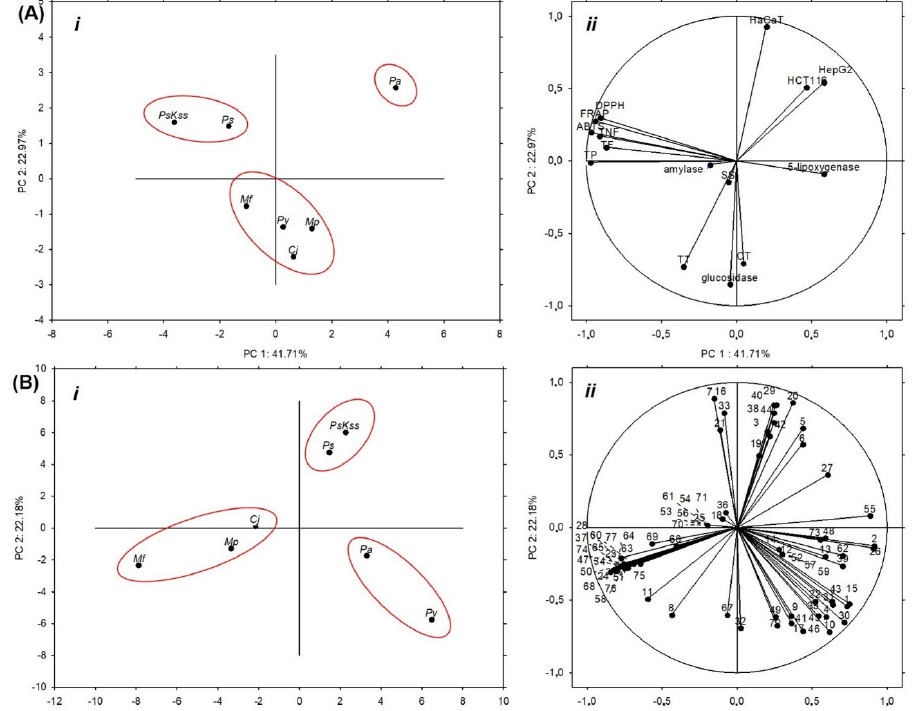
Figure 2. Principal component analysis of ( A ) the groups of metabolites, antioxidant capacity, cy- totoxicity, antidiabetic and anti-inflammatory potential of Rosaceae inflorescences: ( i ) score plot separating the inflorescence samples based on the measured groups of metabolites, antioxidant capacity, cytotoxicity, and antidiabetic and anti-inflammatory potential, and ( ii ) loading plot of the measured variables; ( B ) the individual identified phenolic compounds in Rosaceae inflorescences: ( i ) score plot separating the inflorescence samples based on the individual identified phenolic com- pounds they contain, and ( ii ) the loading plot of the individual phenolics as variables. Pa = P. avium , Ps = P. serrulata , PsKss = P. serrulata ‘Kiku Shidare Zakura’, Py = P. yedoensis , Mp = M. purpurea , Mf = M. floribunda , Cj = Chaenomeles japonica , TP = total phenolics, TF = total flavonoids, TNF = total nonflavonoids, TT = total tannins, CT = condensed tannins, SS = soluble sugars, ABTS = 2,2 (cid:48) -azino- bis(3-ethylbenzothiazoline-6-sulfonic acid) diammonium salt, FRAP = ferric reducing antioxidant power, DPPH = 2,2-diphenyl-1-picrylhydrazyl, 1–77 = numbers related to the individual identified phenolics, as depicted in the Table